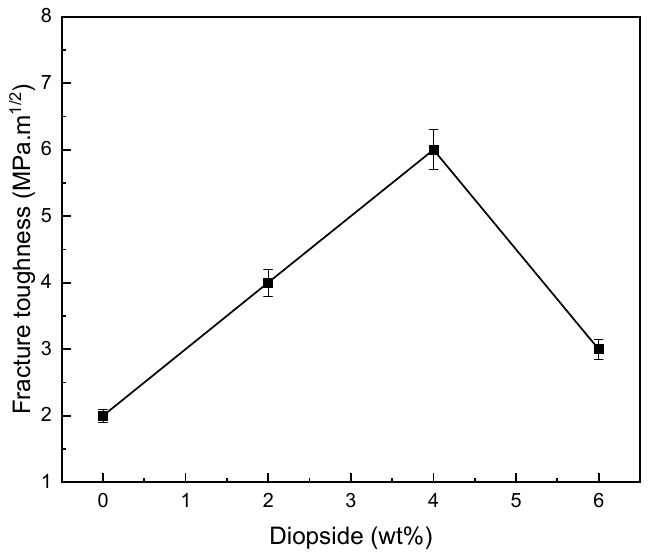
Figure 9. Fracture toughness of glass ionomer and glass ionomer diopside with different weight percent.